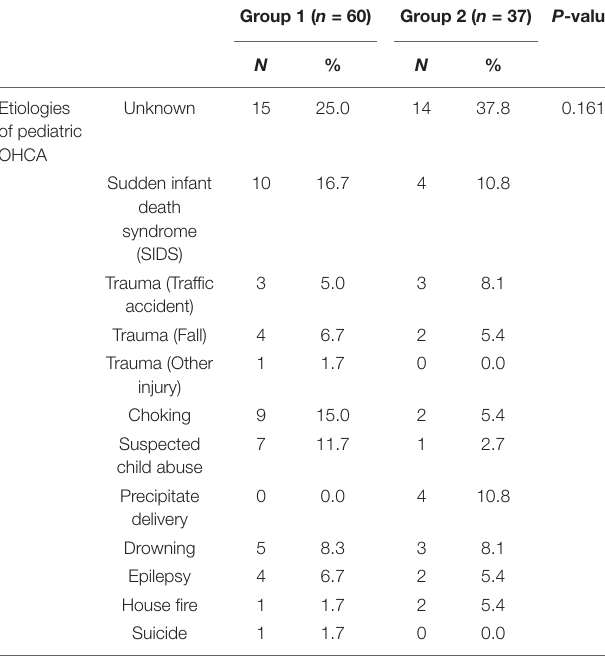
TABLE 2 | Manner of pediatric OHCA. TABLE 3 | Comparison of rapid pediatric advanced life support (PALS) and time